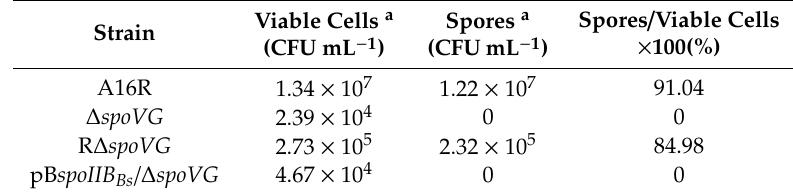
Table 2. E ff ect of SpoIIB Bs complementation on sporulation of the B. anthracis ∆ spoVG strain. Table 2. Effect of SpoIIB Bs complementation on sporulation of the B. anthracis Δ spoVG strain. Viable Cells a Spores a Viable cells a Spores a Strain Strain (CFU mL − 1 ) (CFU mL − 1 ) (CFU mL −1 )